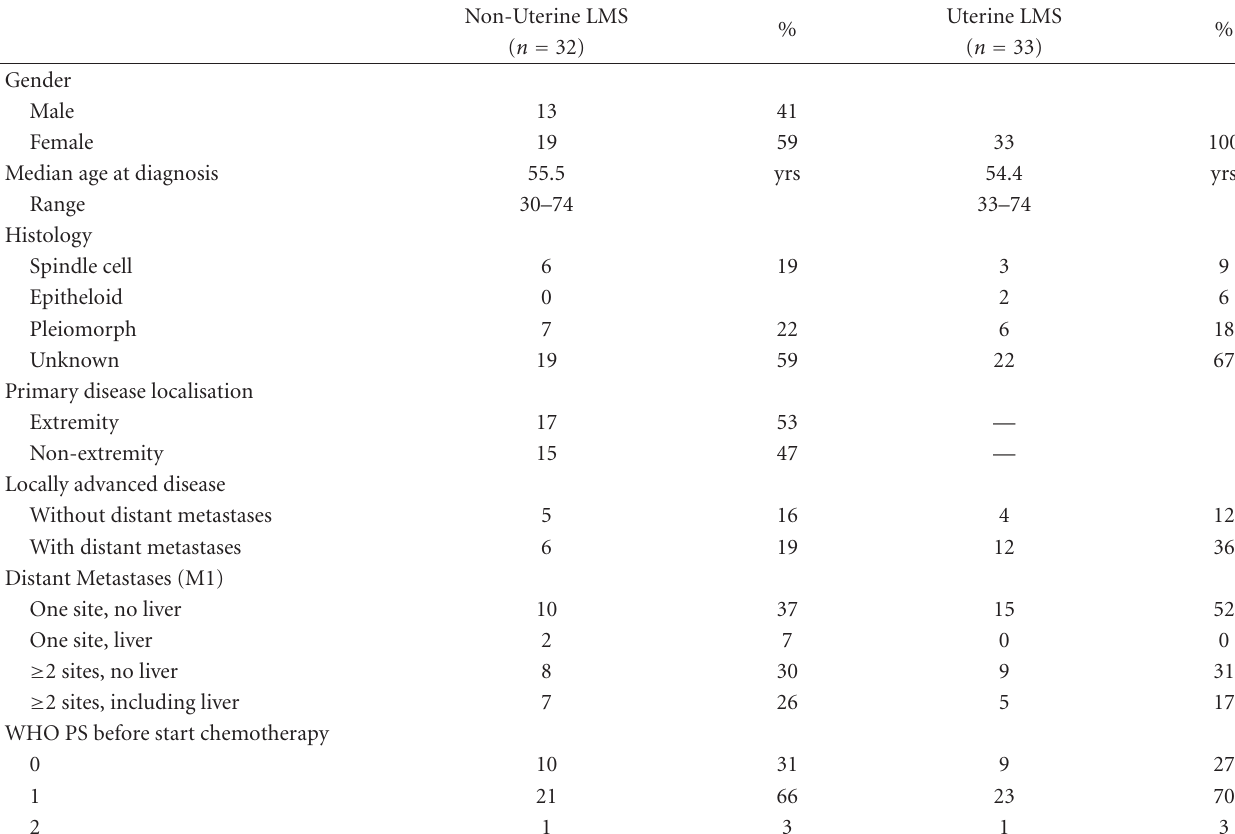
Table 1: Patient characteristics, n = 65.